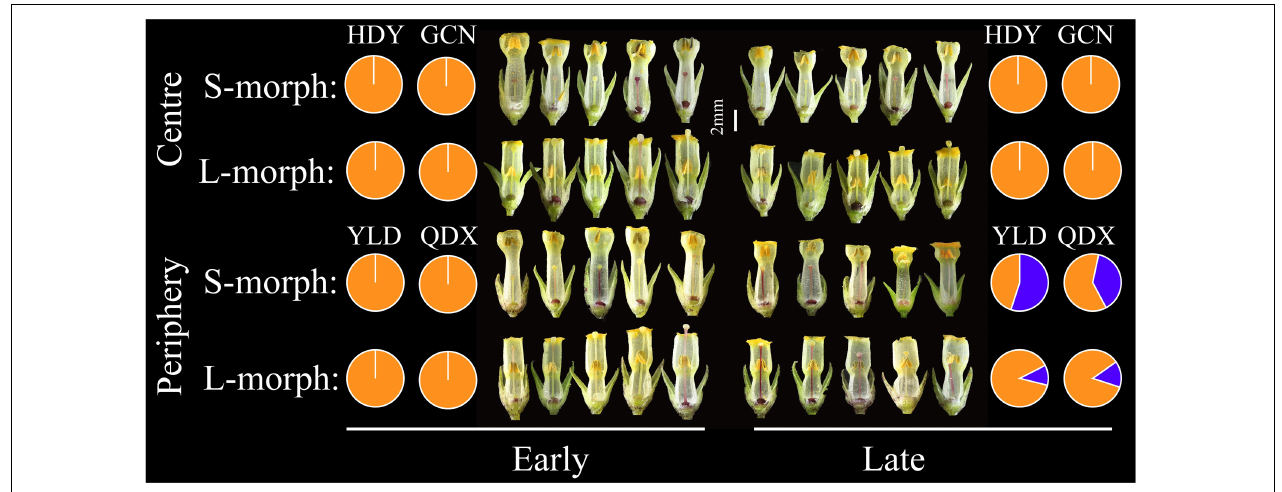
FIGURE 5 | Spatiotemporal variation in floral traits of P. wannanensis plants. Orange and blue sections of the pie chart indicate herkogamy values greater than 0 mm and equal to 0 mm, respectively.